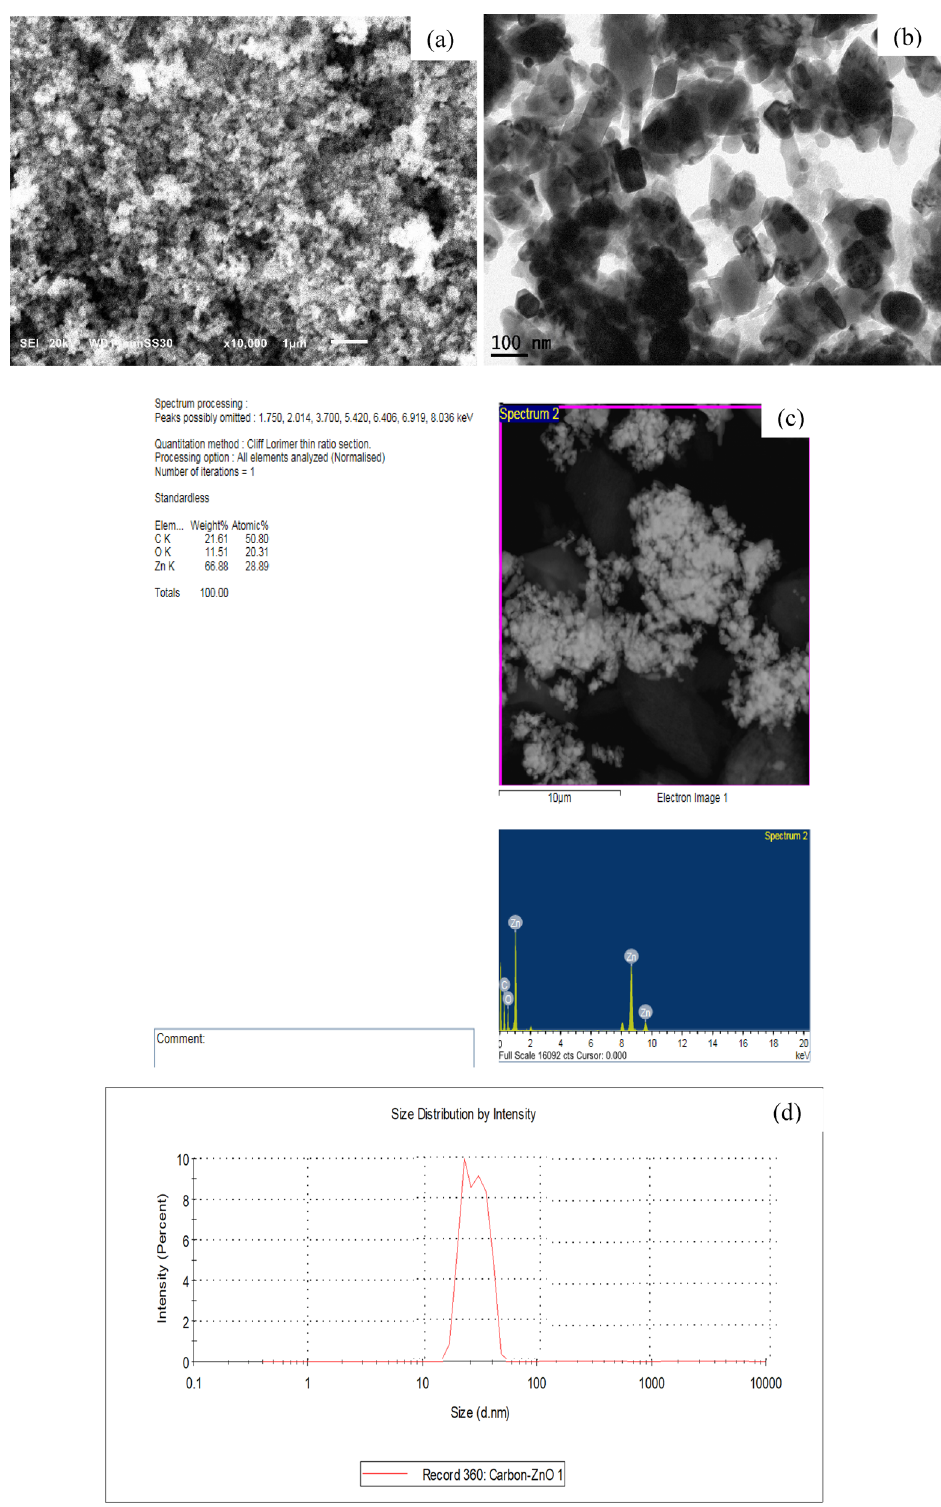
Figure 6. ( a ) SEM, ( b ) TEM, ( c ) EDX, and ( d ) size distribution images of the synthesized (Z3C1)